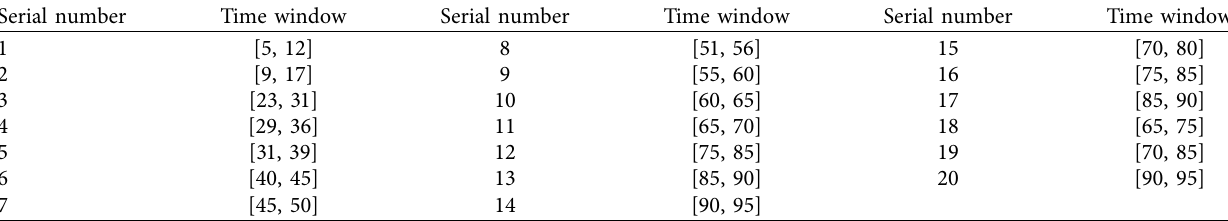
Table 10: Time windows for the distribution to retailers/consumers.